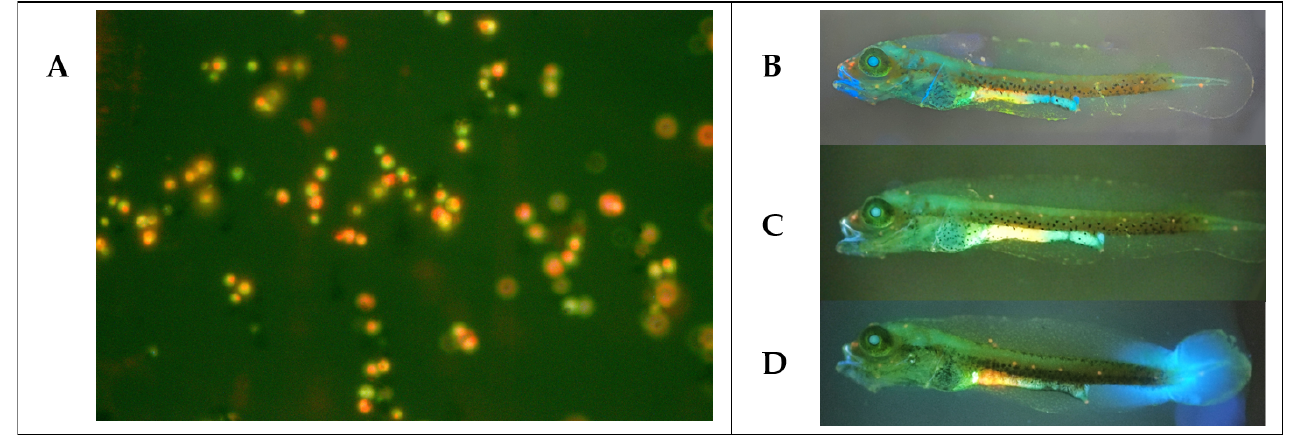
Figure 4. Yeast strains were observed in the intestines of cobia larvae after being inoculated by immersion with labeled yeast strains. ( A ) D. hansenii C10 stained with acridine orange (40 × ). ( B ) Cobia larvae (2 dph) after 1 h of being inoculated by immersion with stained D. hansenii C10, ( C ) C. haemuloni C27, and ( D ) D. hansenii C28 (4 × ).